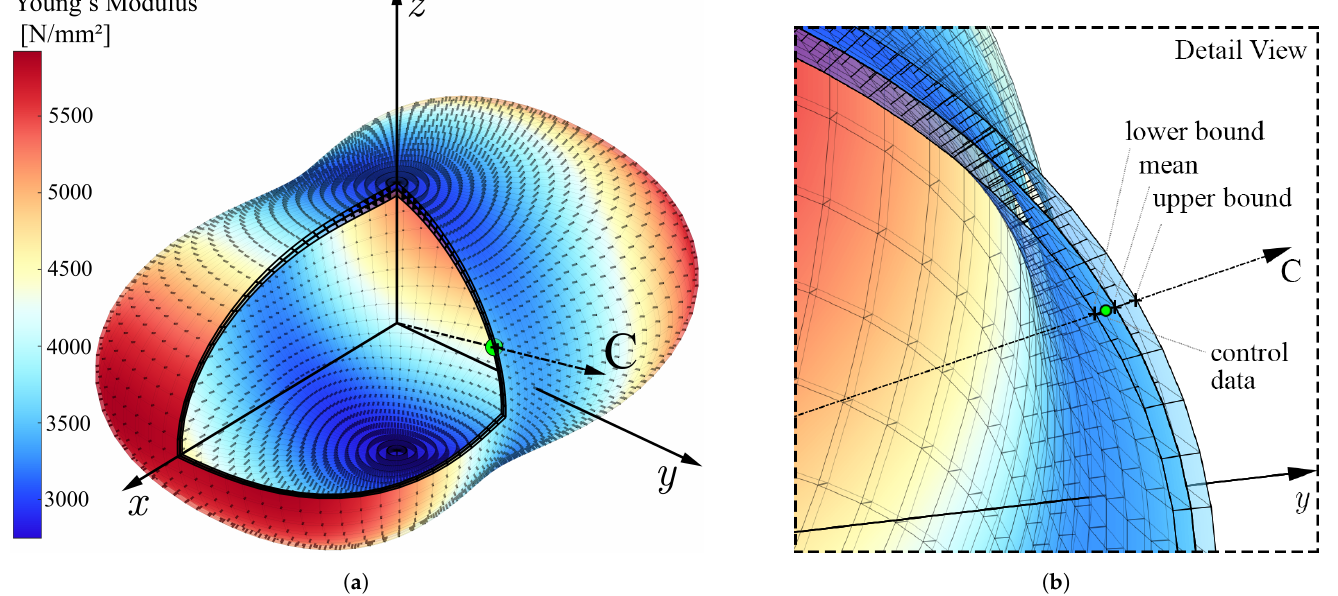
Figure 9. ( a ) Visualization of anisotropy in Young’s modulus for an element of t = 1.8mm, with mean, upper and lower standard deviation bounds represented by the three surface plots and ( b ) detailed view of the experimentally obtained control data point of coupon C indicated by the green